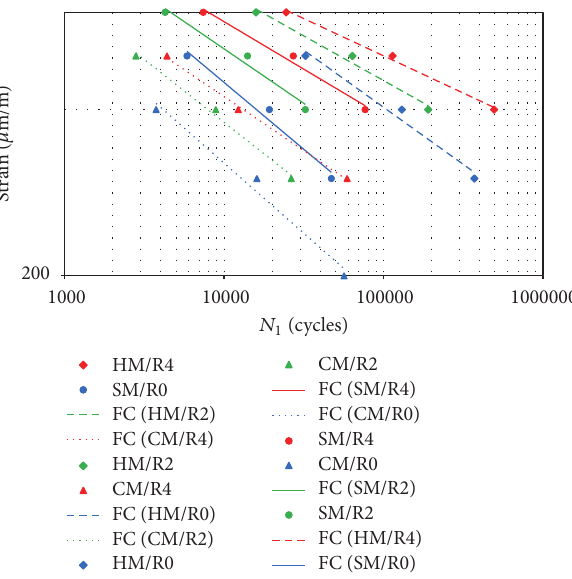
Figure 6: Fatigue life 𝑁 1 versus initial strain: unaged mixes.